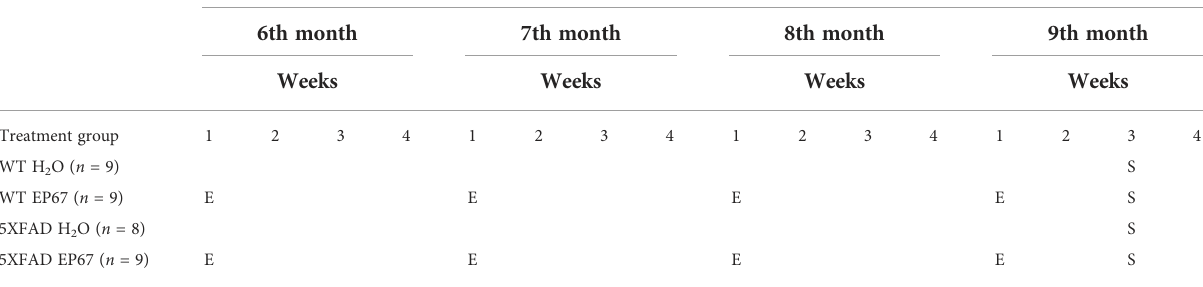
TABLE 1 Mice treatment